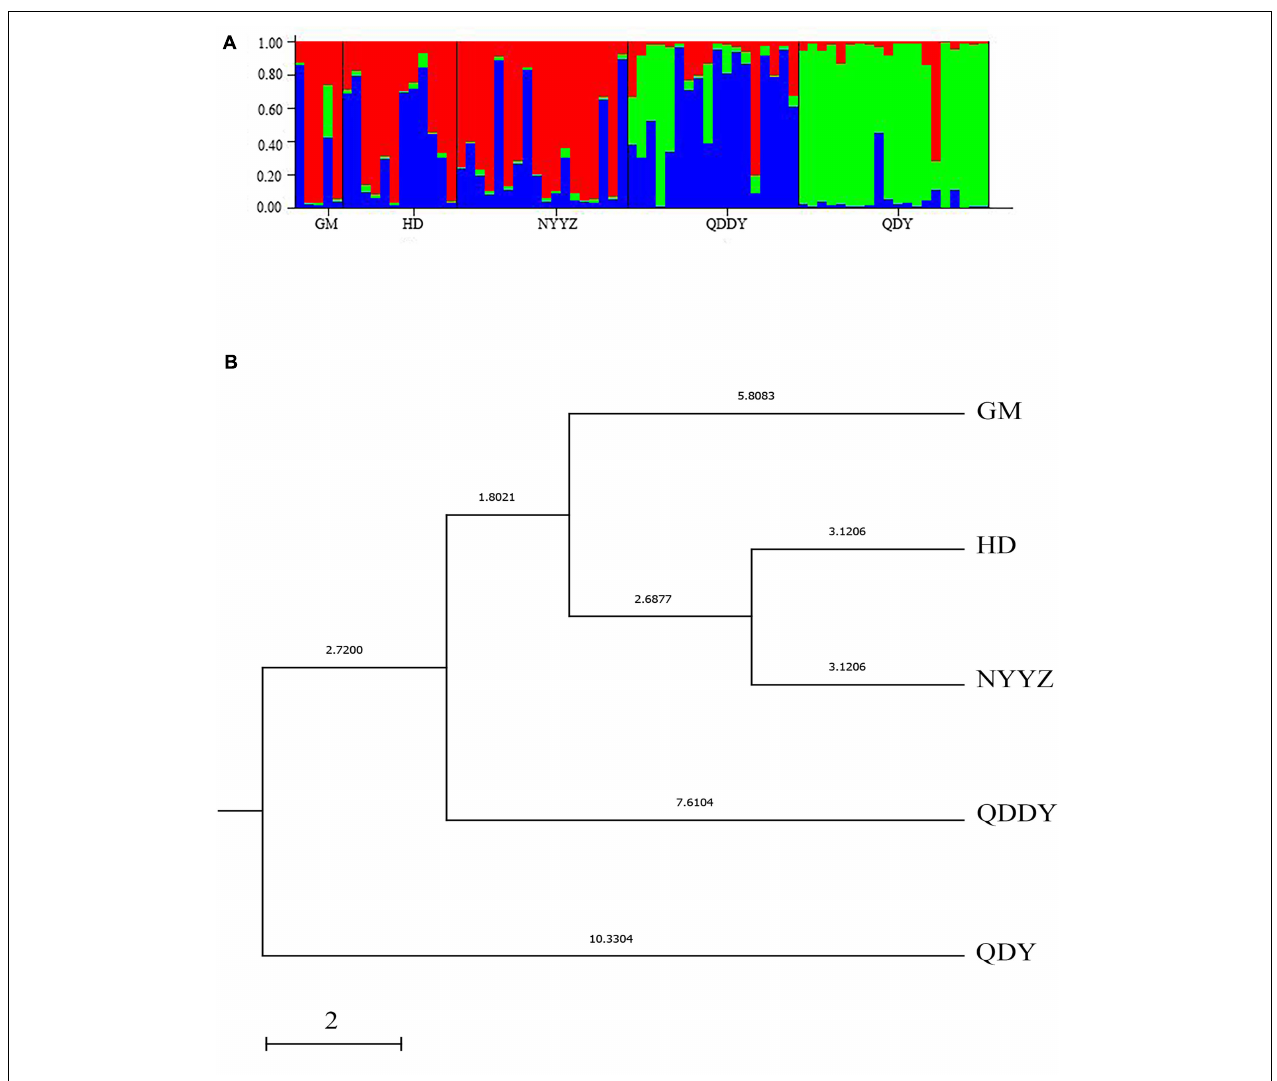
FIGURE 3 | STRUCTURE cluster analysis of the five populations. These populations were grouped in three ancestral clusters (A) . The UPGMA tree from 12 microsatellite loci of 5 M. vulgaris populations (B)